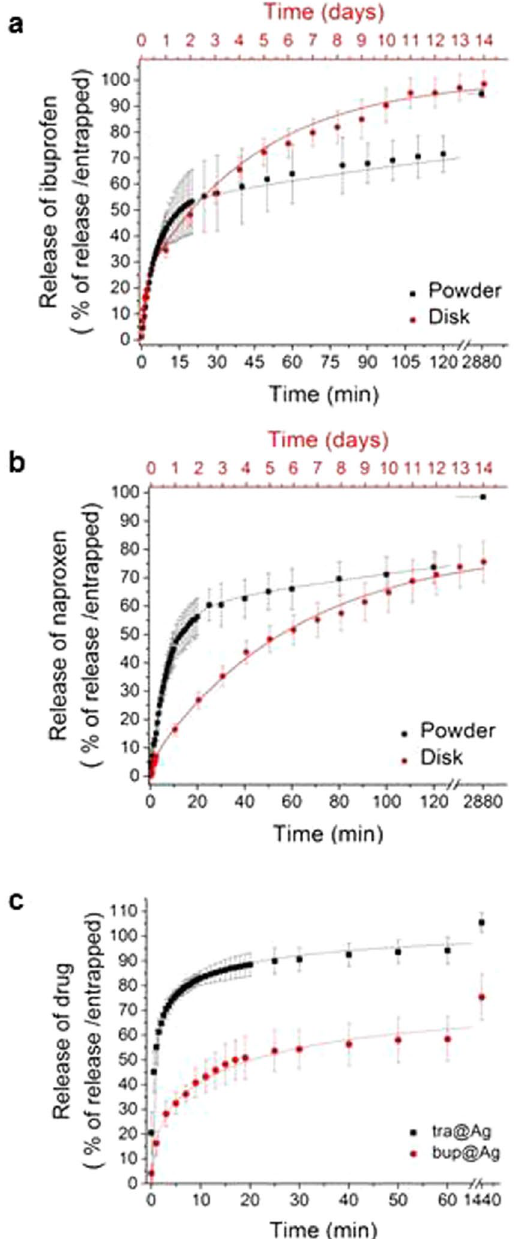
Figure 4. Drug release profiles of ( a ) ibuprofen and ( b ) naproxen from their metallic silver matrices. Black squares: Powder, Red circles: Compressed discs (note the different time scales). Full lines: Fits to the kinetic model of eq. (1) (Table 3; range of fit: 120 min). ( c ) Sustained release of tramadol (black squares) and of bupivacaine (red circles) from their metallic silver matrices composites. Full line: The fit to Weibull equation (equation (2), Table 4 (range of fit: 60